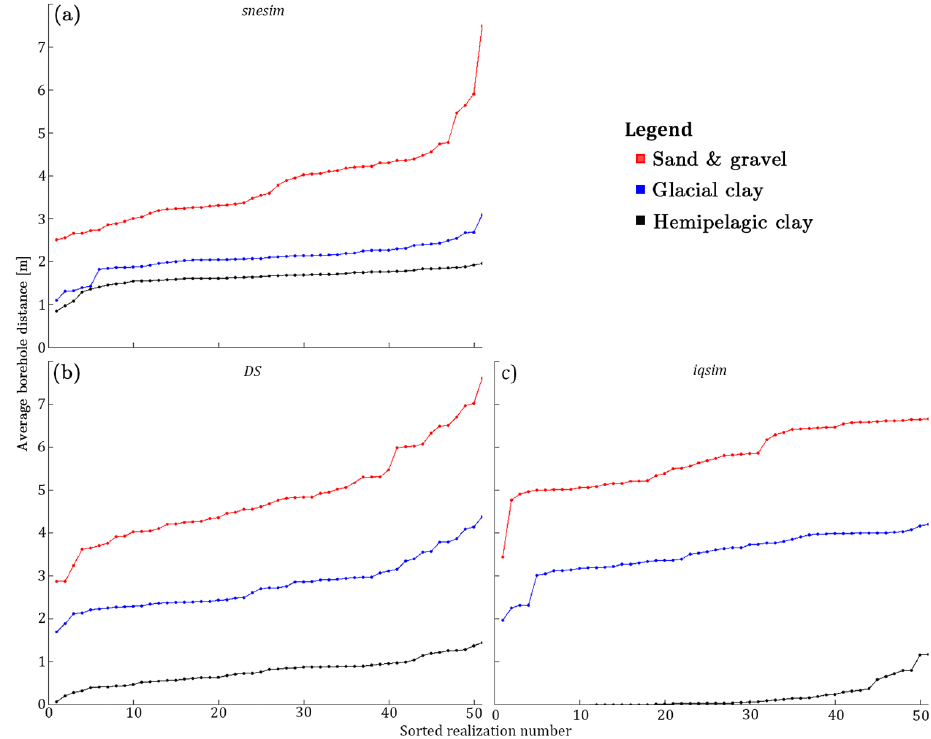
Figure 10. The borehole distance results are presented for each of the three MPS methods: snesim, DS and iqsim. (a) shows the snesim borehole distance results for the three hydrostratigraphic units, (b) shows the DS borehole distance results for the three hydrostratigraphic units, and (c) shows the iqsim borehole distance results for the three hydrostratigraphic